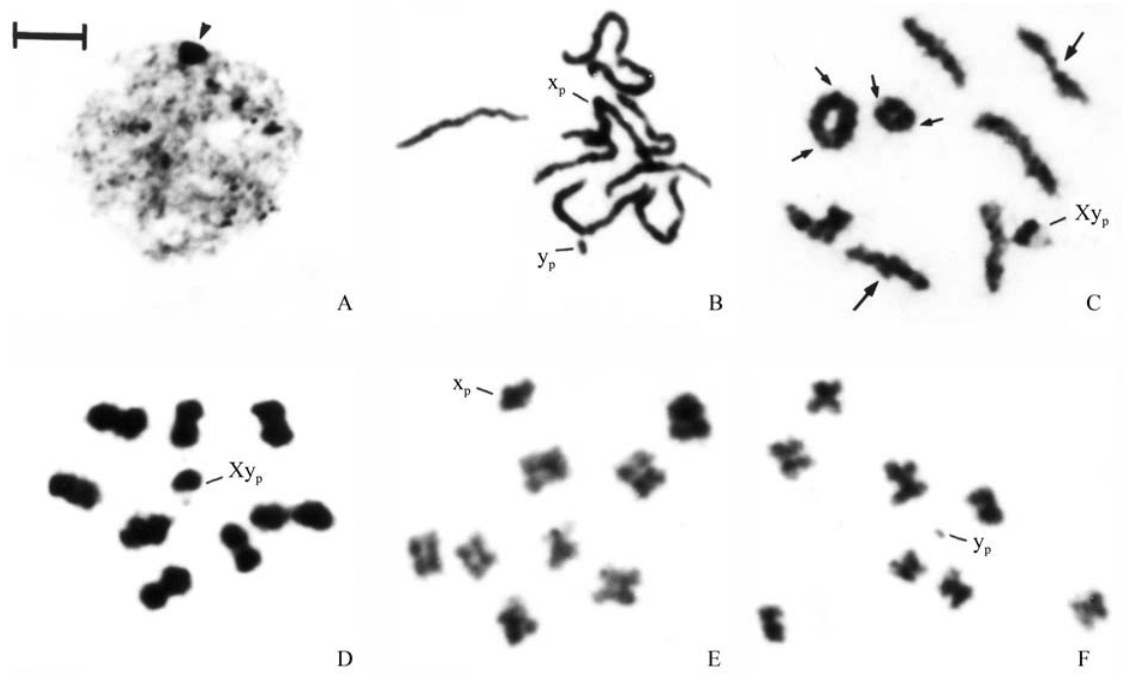
Figure 2 - Spermatocytes of Astylus variegatus : A) Interphase, with a prominent heteropycnotic block (arrowhead); B) Pachytene, with eight synapsed autosomal bivalents and two unpaired sex chromosomes; C-D) Diplotene and metaphase I, respectively, with 2n = 8II+Xy p and sex chromosomes in a parachute configuration. In C, note the presence of one (large arrow) or two (small arrow) terminal chiasmata in the bivalents; E-F) Metaphase II cells, with n = 8+X p and n = 8+y p , respectively. Scale bar = 5 μ